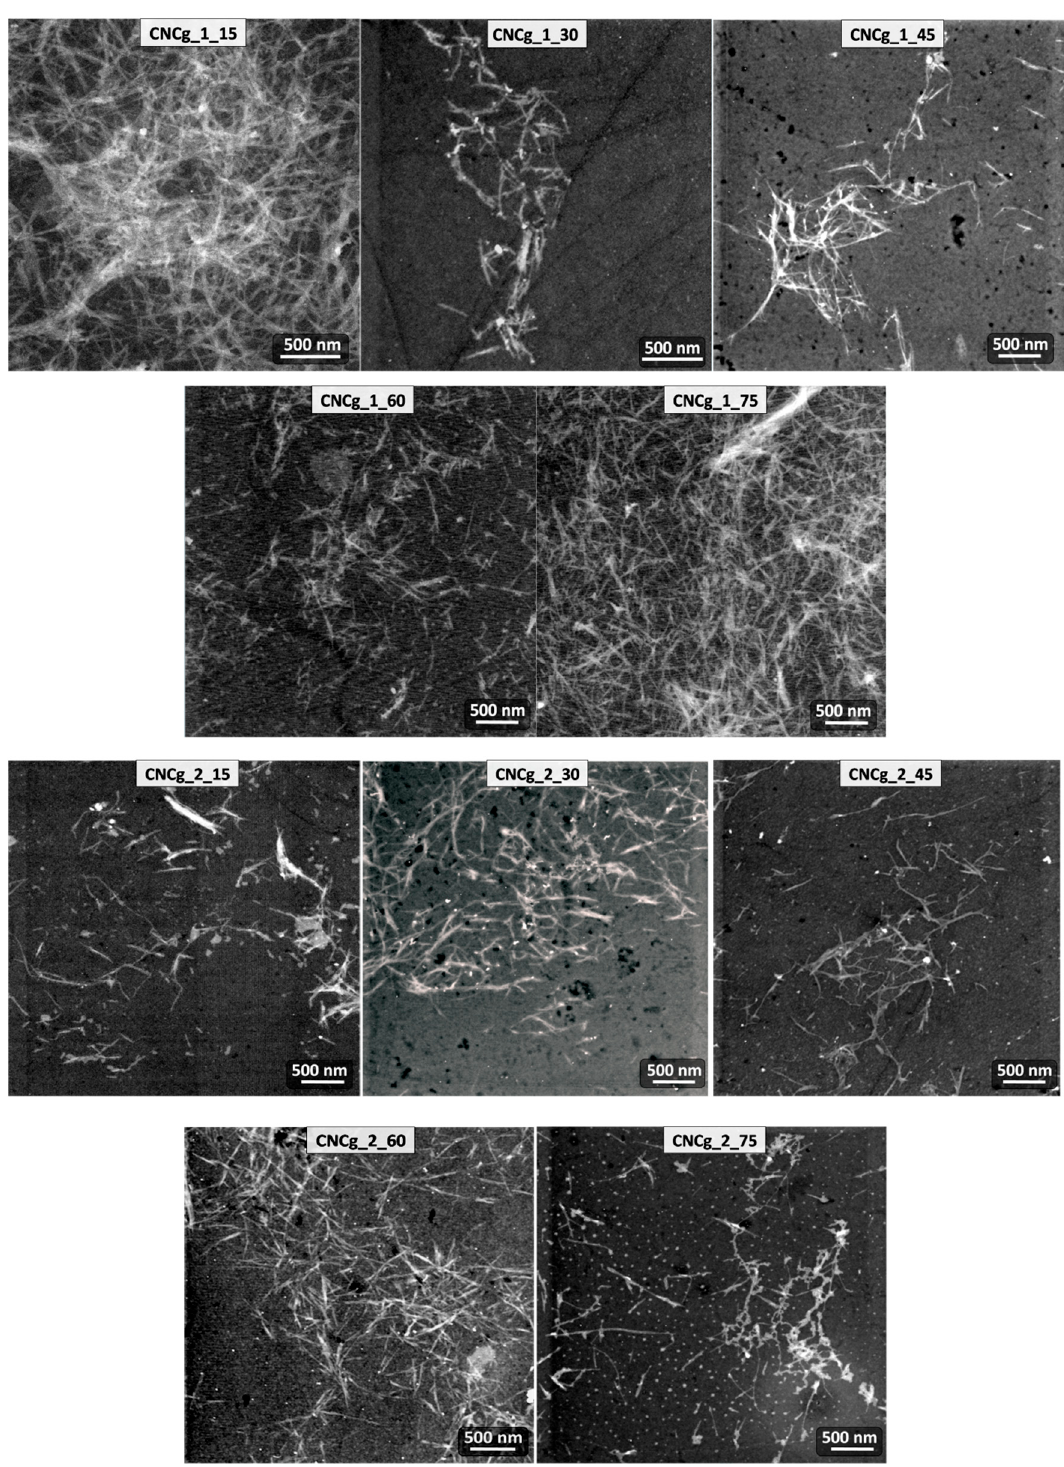
Figure 8. TEM micrographs of the CNCg samples with their respective encodings .